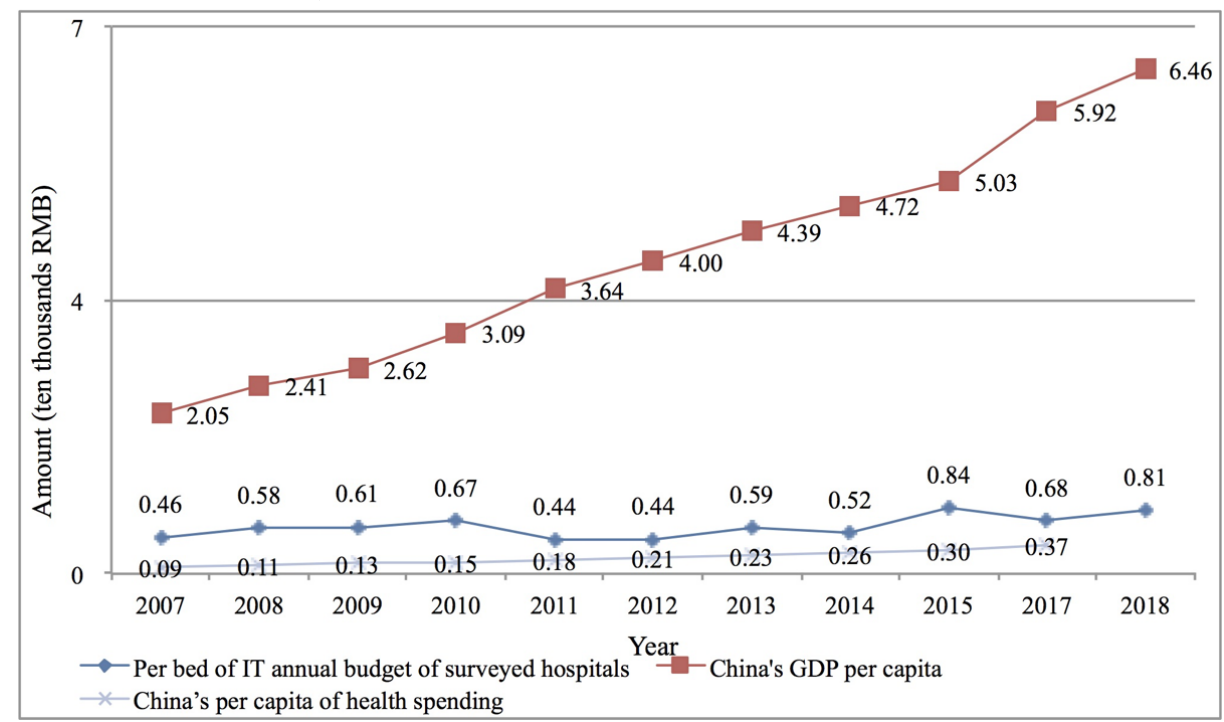
Figure 8. China’s per capita gross domestic product, medical expenditure per capita, and information technology investment per hospital bed from 2007 to 2018. IT: information technology; GDP: gross domestic product. (Note: As of the date of submission, the per capita health spending data for China in 2018 has not been